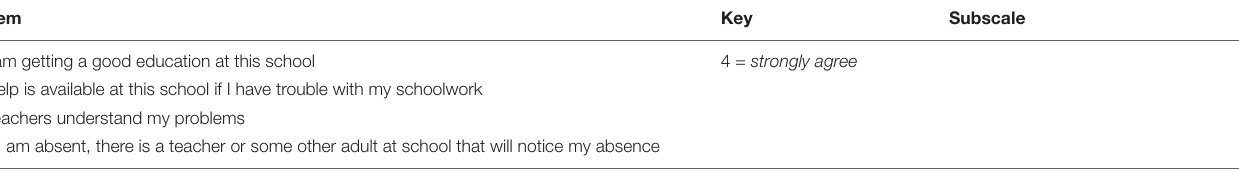
TABLE 3 | Goodness-of-fit indices for proposed models.